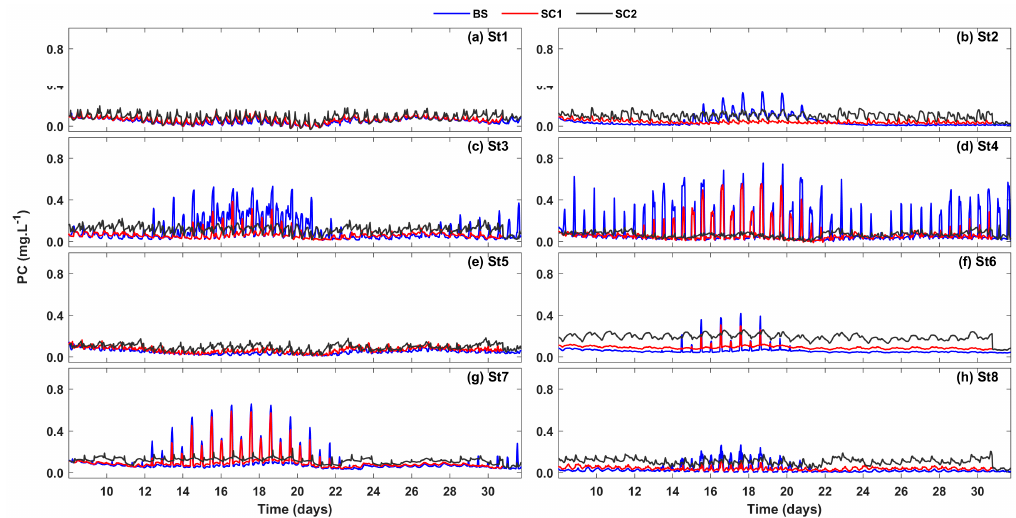
Figure 15. Time series of the carbon phytoplankton concentration, PC, for the scenarios, BS, SC1, and SC2, for September 2000, and the lagoon stations: ( a ) St1, ( b ) St2, ( c ) St3, ( d ) St4, ( e ) St5, ( f ) St6, ( g ) St7 and ( h ) St8.